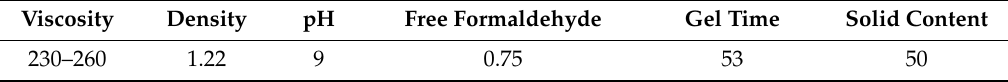
Table 1. Specifications of urea-formaldehyde.